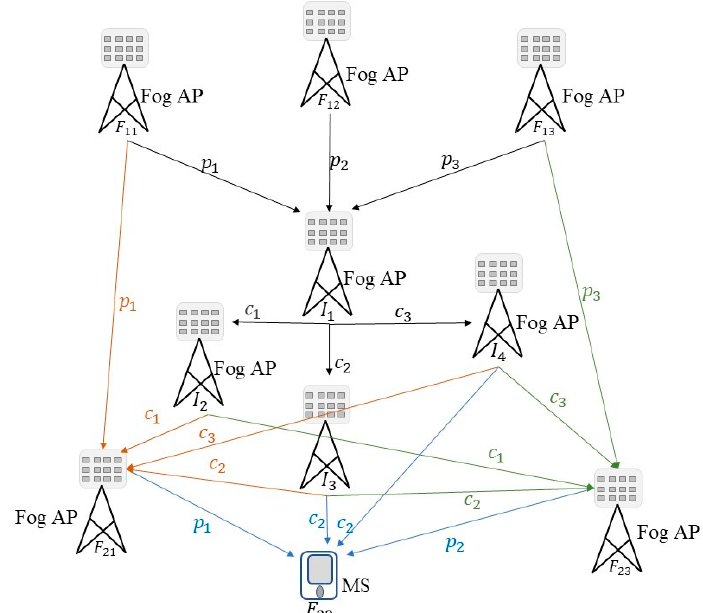
Figure 3. MmWave fog access points network topology.